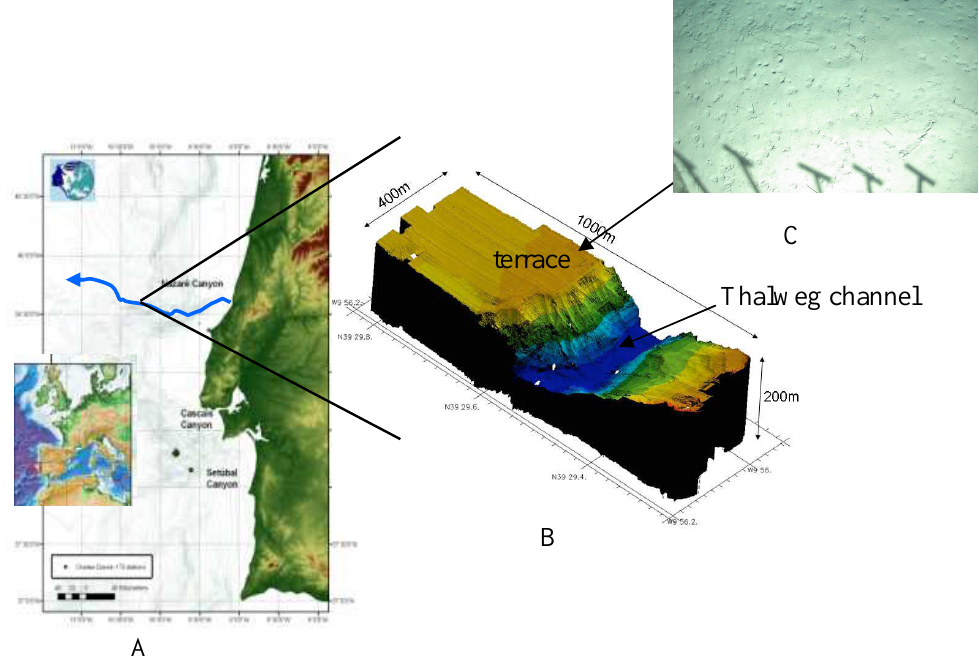
Fig. 1. Nazar´e Canyon, 3500m site. (A) Chart of the bathymetry of the Portuguese margin (GEBCO, 2003), showing the location the Nazar´e Canyon; (B) ROV high resolution swath bathymetry of the central thalweg channel of the Nazar´e canyon at 3500m. The steep channel wall is composed of rock outcrop. The channel floor has boulders with a thin drape of mud. (C) Terrace to the north of the thalweg is characterised by burrowing animals as seen by the burrows and feeding pits in the photograph (Modified after, Masson et al.,